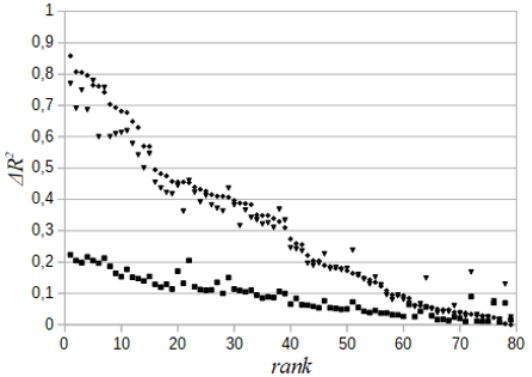
Fig. 5. Results for difference between long models (4a) and short models (4b).